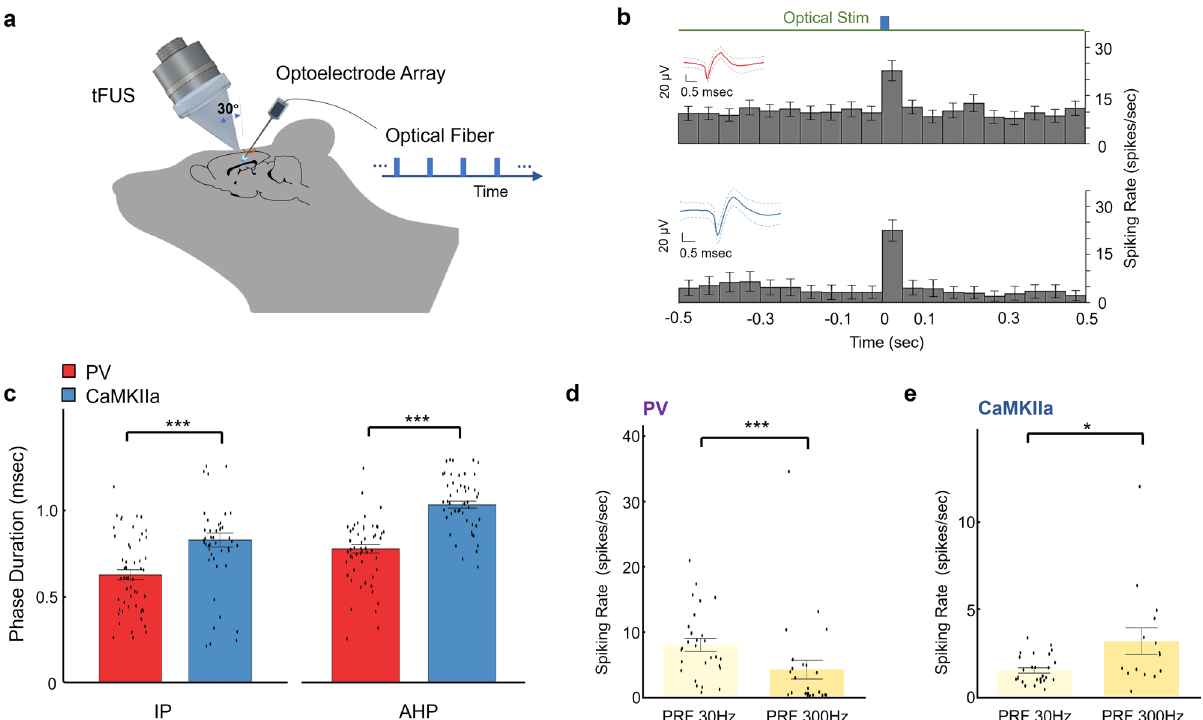
Fig. 7 Validation of PRF preferences of inhibitory and excitatory neurons. a A mouse-speci fi c 3D-printed collimator guiding tFUS to hair-removed scalp of an anesthetized transgenic mouse model (2% iso fl urane, 2 mg/kg bupivacaine subcutaneously) with an incidence angle of 30°, and a 32-channel optoelectrode array inserted at another incidence angle of 40° into the left S1 prepared through a craniotomy. The blue light stimuli were pulsed using a PlexBright LD-1 Single-Channel LED driver at 30 mA and were then delivered via optical fi ber (105 μ m diameter) to the recoding side of the shank. b The PSTHs (bin size: 50 ms) of one PV spiking unit (upper panel, 258 trials for each time bin, IP duration mean: 550 μ s; AHP duration mean: 850 μ s) and one CaMKIIa spiking unit (lower panel, 128 trials for each time bin, IP duration mean: 600 μ s; AHP duration mean: 1100 μ s) responding to the optical stimuli. Spike waveforms depicted as insets in b , solid red line as the mean waveform, dashed lines as the waveform standard deviation. Data are shown in the PSTHs as the mean ± 95% con fi dence interval. c Comparing PV ( n = 53) and CaMKIIa ( n = 50) neurons regarding the IP (PV vs. CaMKIIa: p = 6 × 10 − 5 ) and AHP (PV vs. CaMKIIa: p = 3 × 10 − 12 ) phase durations. Data are shown as the mean±s.e.m., statistics by one-tail Wilcoxon test. *** p < 0.001. d , e The comparisons of spiking rates between the tFUS conditions of PRF 30 Hz ( n = 28 for PV neurons, n = 27 for CaMKIIa neurons) and PRF 300 Hz ( n = 25 for PV neurons, n = 15 for CaMKIIa neurons) on PV ( d ) (PRF 30 Hz vs. PRF 300 Hz: p = 2 × 10 − 4 ) and CaMKIIa ( e ) (PRF 30 Hz vs. PRF 300 Hz: p = 0.016) neurons, respectively. Data are shown as the mean±s.e.m., statistics by two-tail Wilcoxon test. * p < 0.05, *** p < 0.001. Source data are provided in the Source Data fi